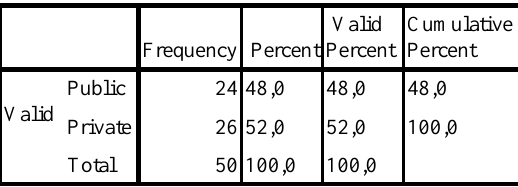
Table 1. Public and Private Sector Distribution